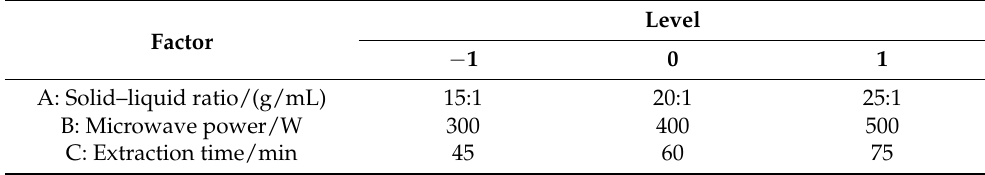
Table 3. Box–Behnken design factors and